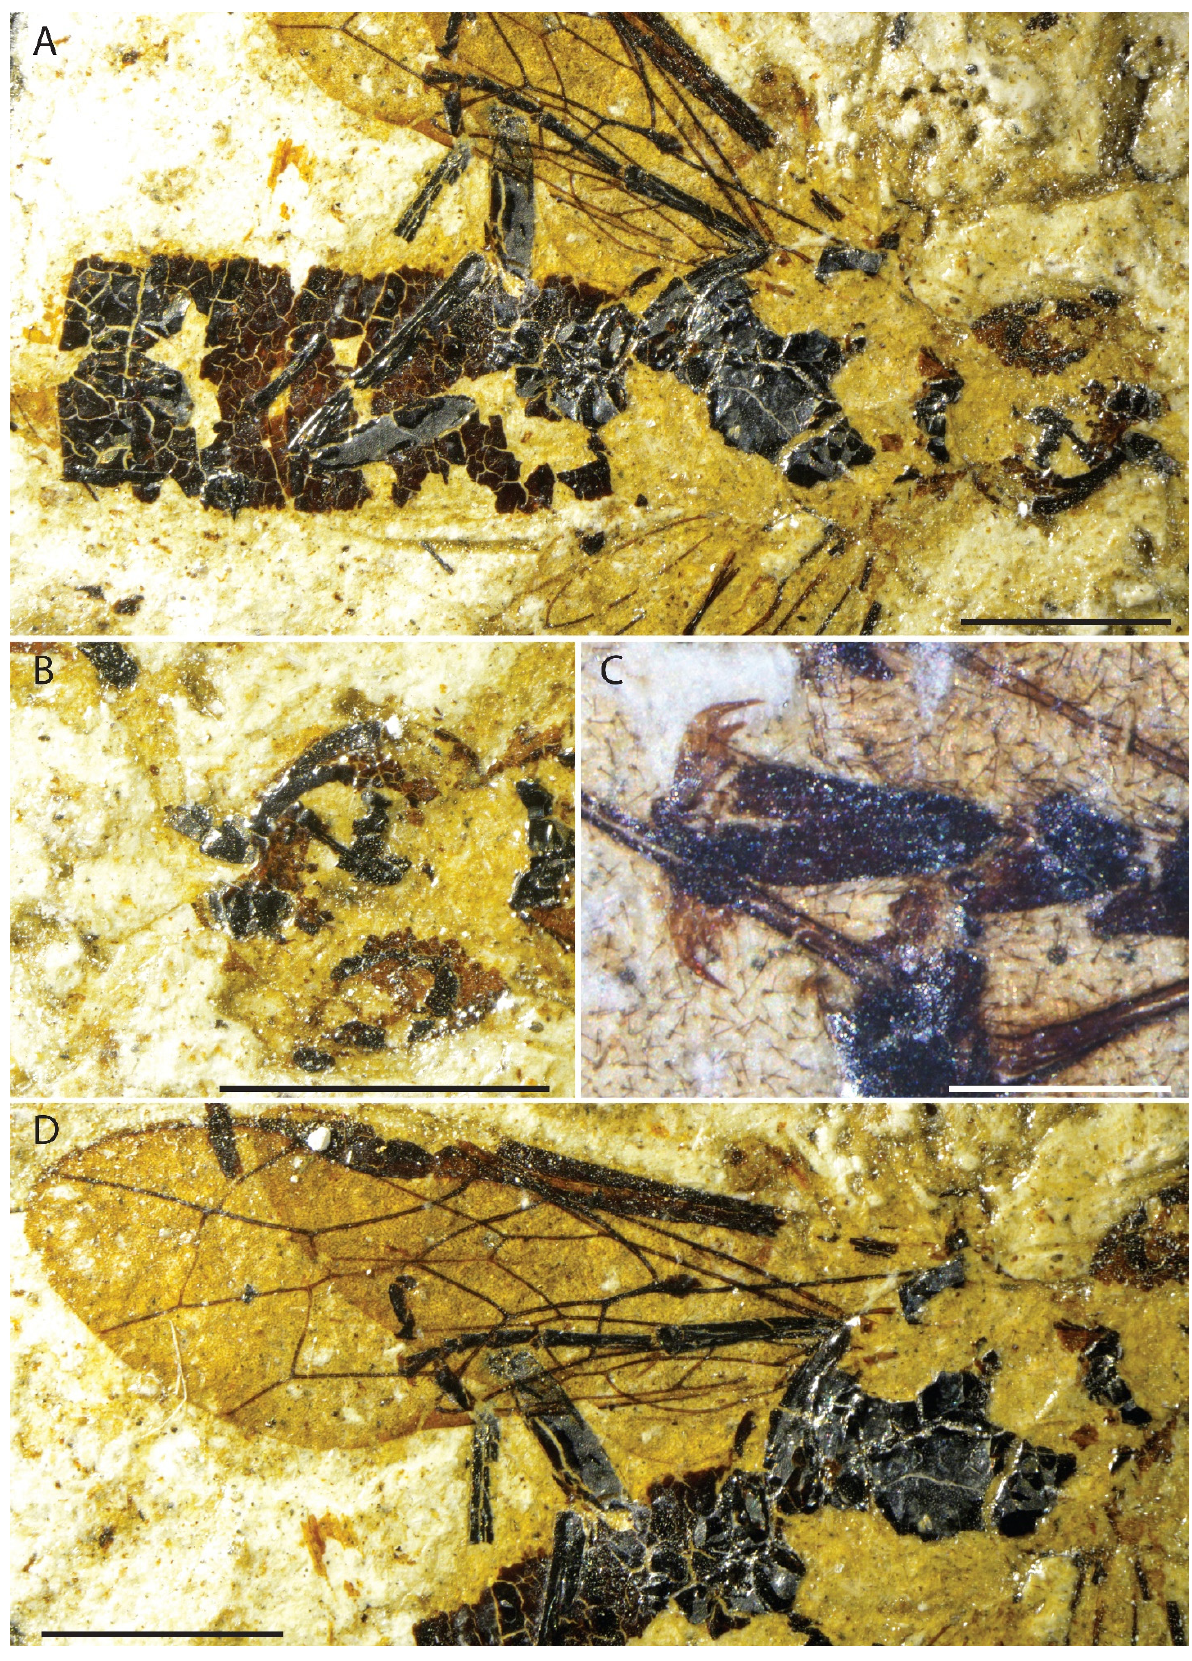
Figure 2. Emphytus miocenicus sp. nov., holotype IGR-PAL-2859. Photographs. ( A ) Body. ( B ) Head. ( C ) Tarsal claw. ( D ) Left fore and hind wings. Scale bars = 2 mm.